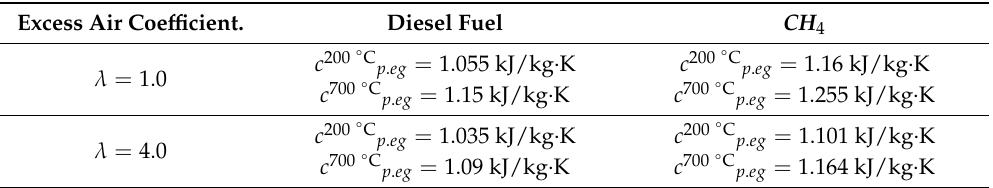
Table 2. c p . is values for approximate evaluation. Excess Air Coe ffi